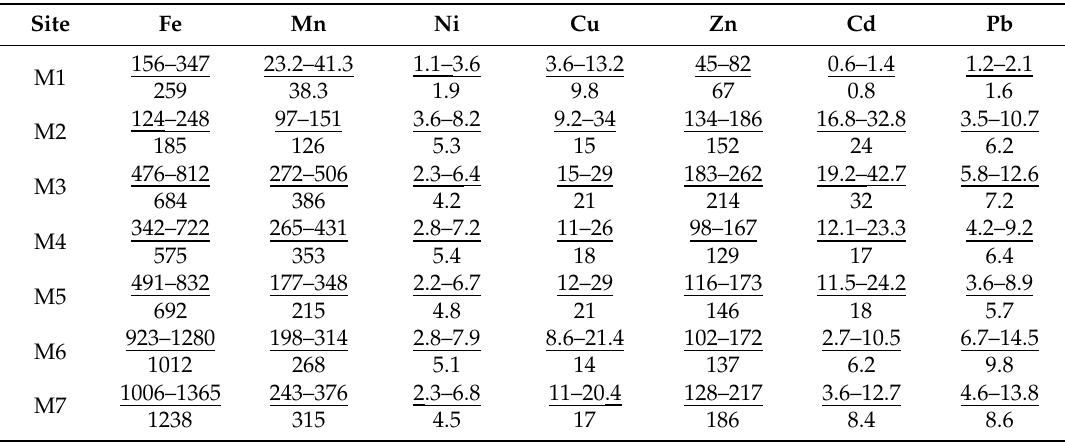
Table 5. The heavy metal concentrations in suspended phase of river Modokul ( µ g · L − 1 ), n = 15—number of